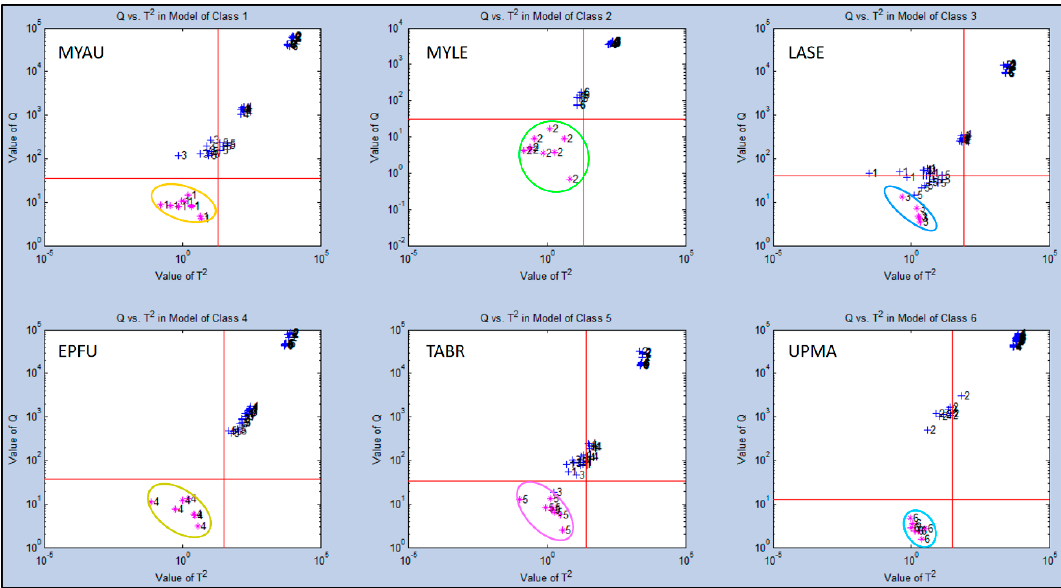
Figure 8. Analysis of aroma class ownership of C-320 e-nose VOC profiles based on bat air samples from five species and ultrapure-air control (Test Group 2) using SIMCA Cross Validation (SIMCA-CV) secondary statistical tests. Analysis of Q-distance (Q-value) vs. score distance (T 2 -value) for each individual VOC aroma class (compared to all other classes) defined by VOC emissions from Class 1 = Myotis austroripiarus (MYAU), Class 2 = Myotis leibii (MYLE), Class 3 = Lasiurus seminolus (LASE), Class 4 = Eptesicus fuscus (EPFU), Class 5 = Tadarida brasiliensis (TABR), and Class 6 = Ultrapure Moist Air (UPMA)